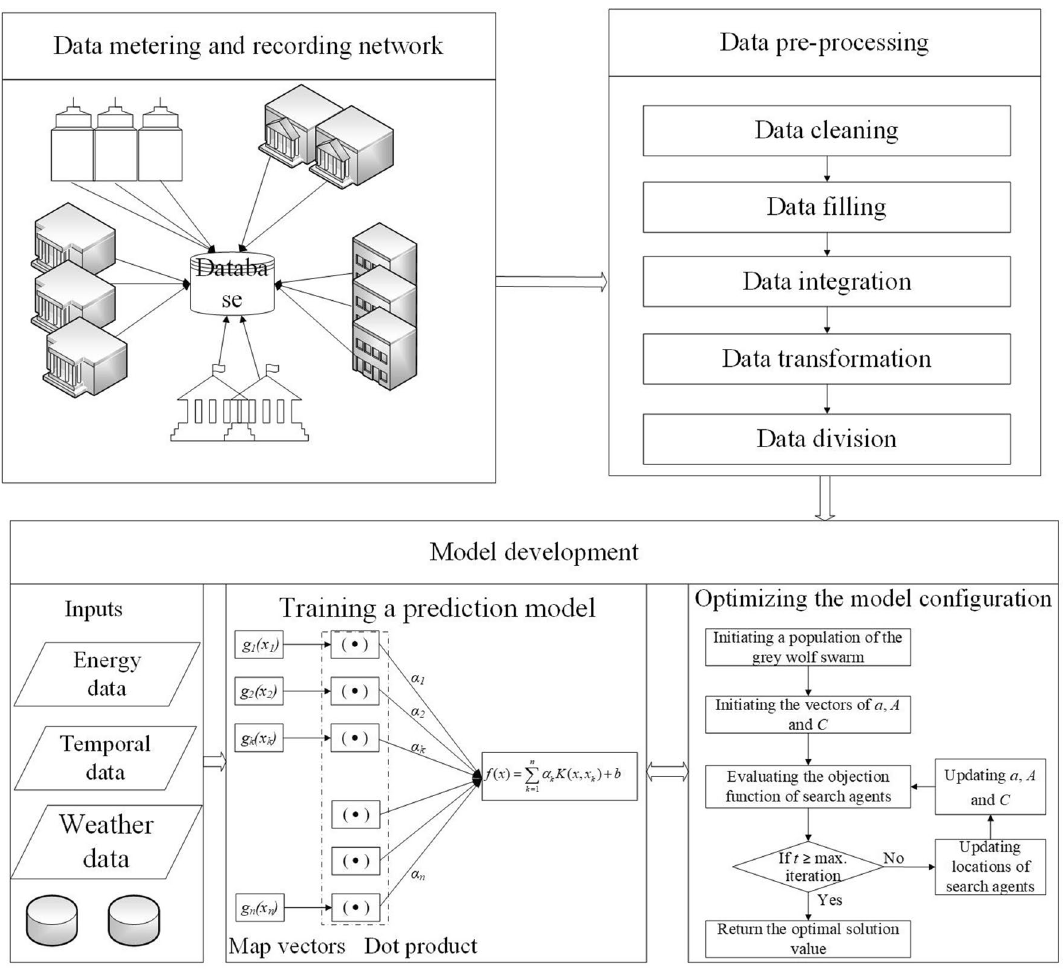
Figure 5. Implementation of wolf-inspired optimization and support vector